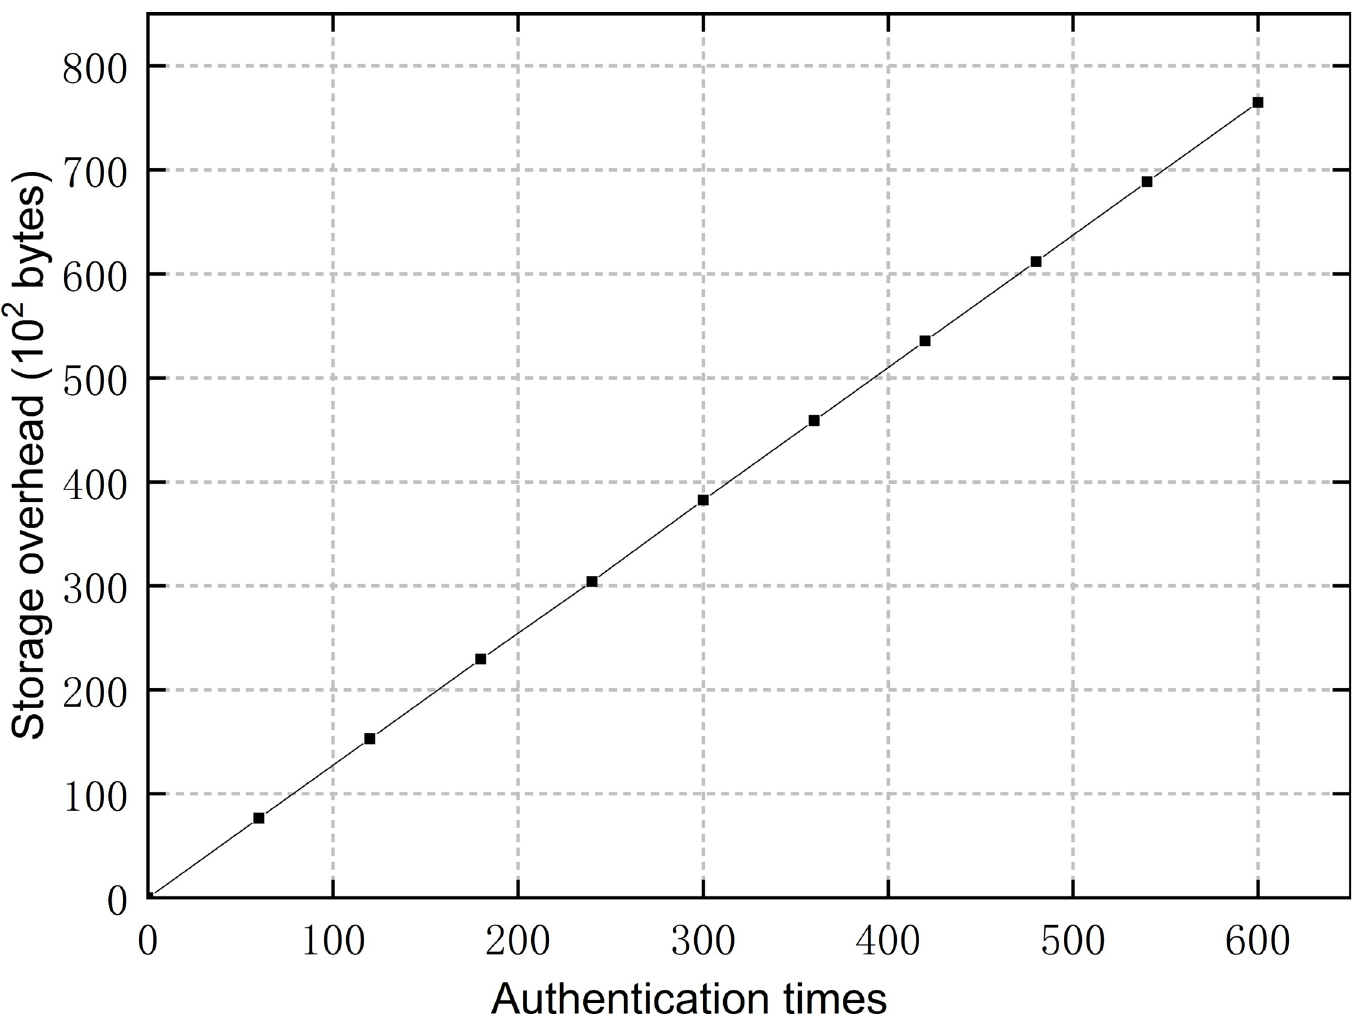
Fig 11. Storage overhead at different authentication